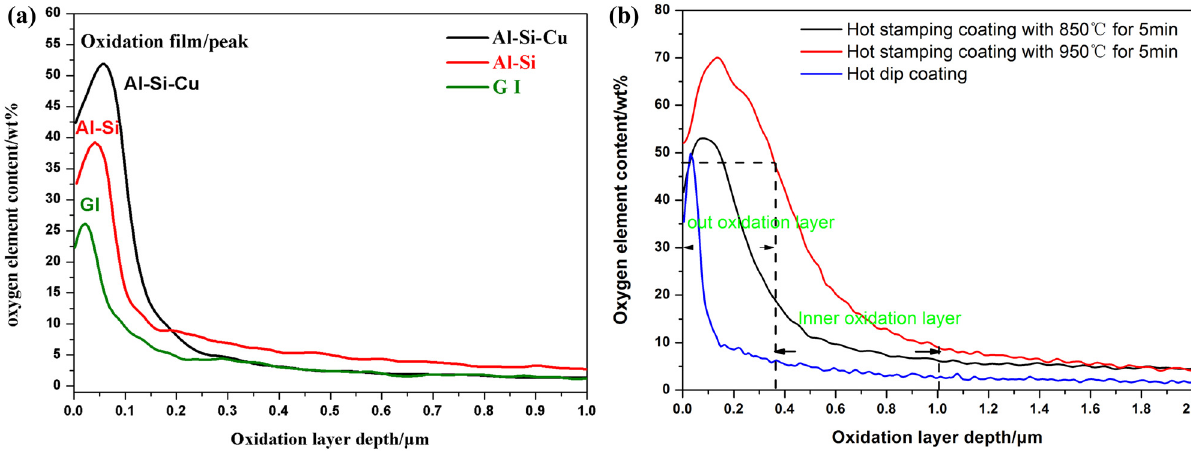
Figure 7: Oxygen element pro fi les of coatings: ( a ) di ff erent hot dip coatings and ( b ) Al – Si – Cu coatings after di ff erent hot stamping